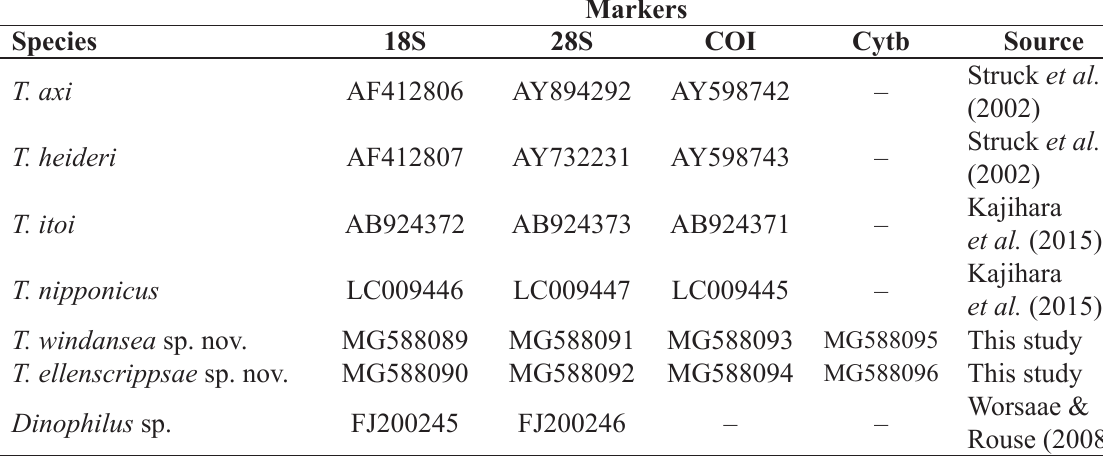
Table 3. List of species and accession numbers included in the phylogenetic analysis. Sequences from T. axi Westheide, 1967 and T. heideri Remane, 1925, were taken from Struck et al. (2002), all sequences from T. itoi Kajihara, Ikoma, Yamasaki & Hiruta, 2015 and T. nipponicus Uchida & Okuda, 1943 were taken from Kajihara et al. (2015), and new sequences for T. windansea sp. nov. and T. ellenscrippsae sp. nov. were generated in this